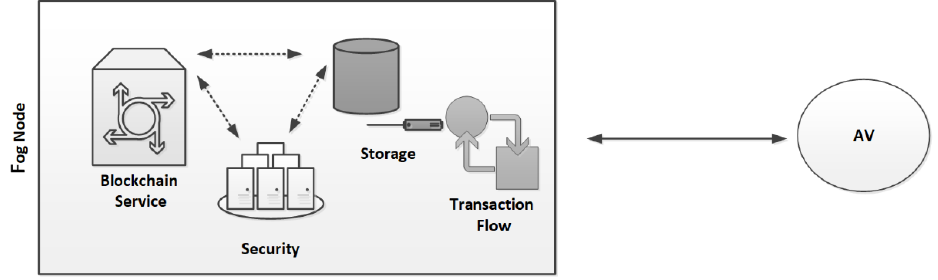
Figure 5. LIBC Module